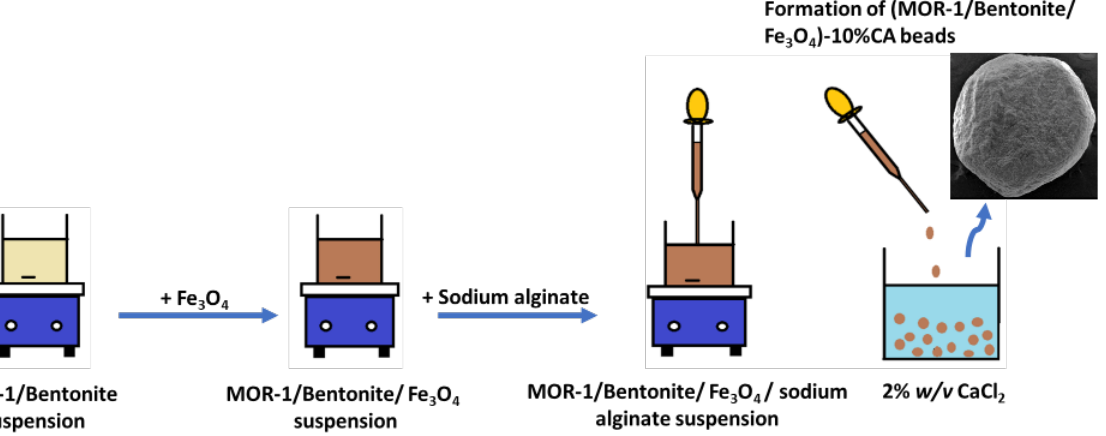
Figure 2. Schematic representation of the preparation of (MOR-1/Bentonite/Fe 3 O 4 )-10%CA beads .